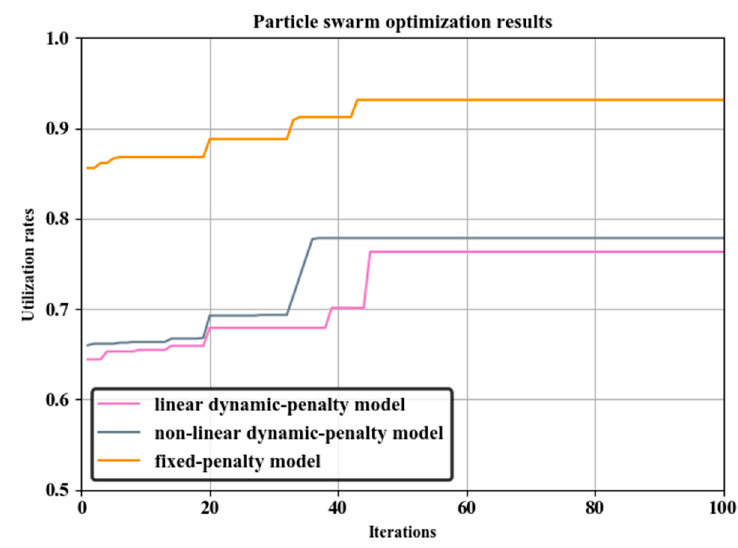
Figure 8. PSO Figure 8. PSO results.